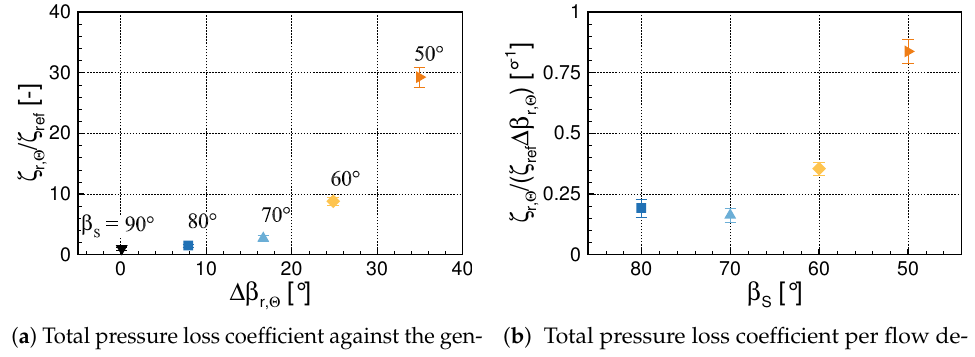
erated flow deflection Figure 9. Overall loss